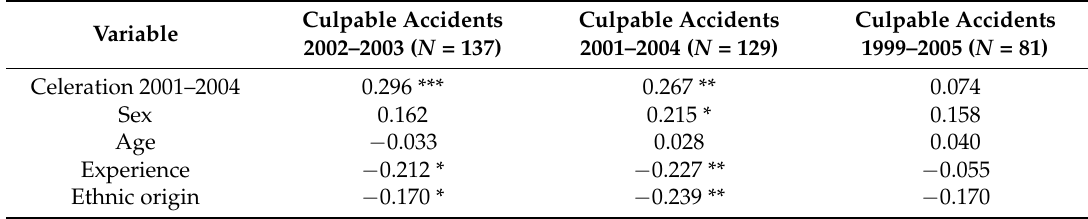
Table 3. The correlations of celeration for drivers with more than ten such measurements for sex, age, experience, and ethnic origin with culpable accident involvement in different time periods, for bus drivers at GUB.